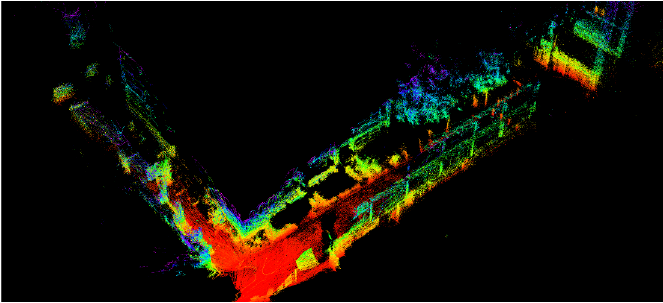
Figure 13. Mapping results of a sharp hook turn